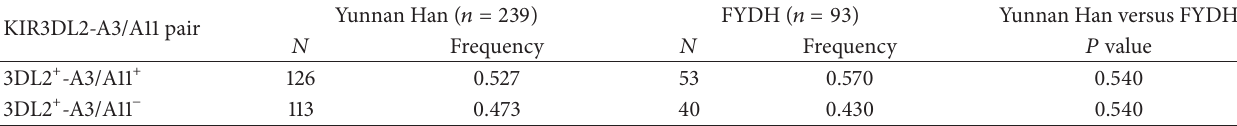
Table 5: Two KIR3D and their ligands HLA-A3 and HLA-A11 in Yunnan Han and FYDH. KIR3DL2-A3/A11